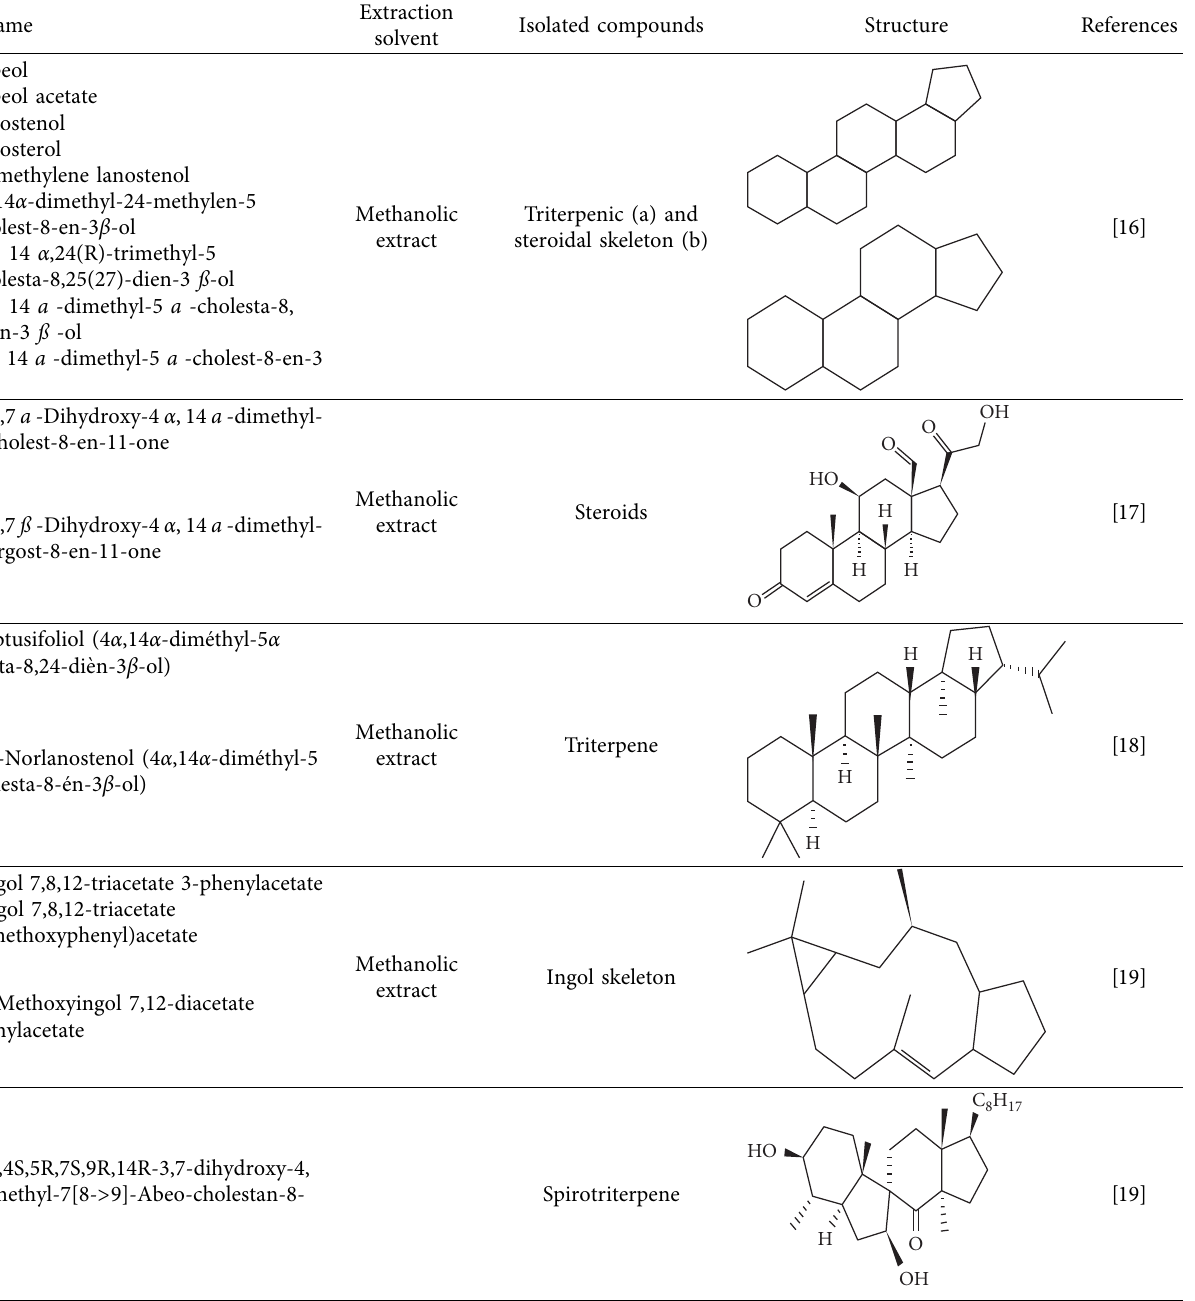
Table 1: Phytoconstituents from E. officinarum latex.